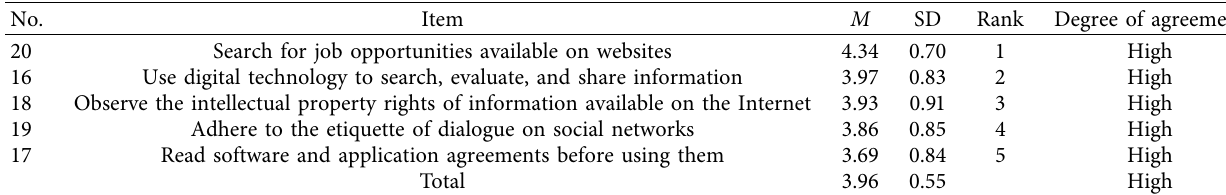
Table 12: Descriptives of digital culture skills in descending order.